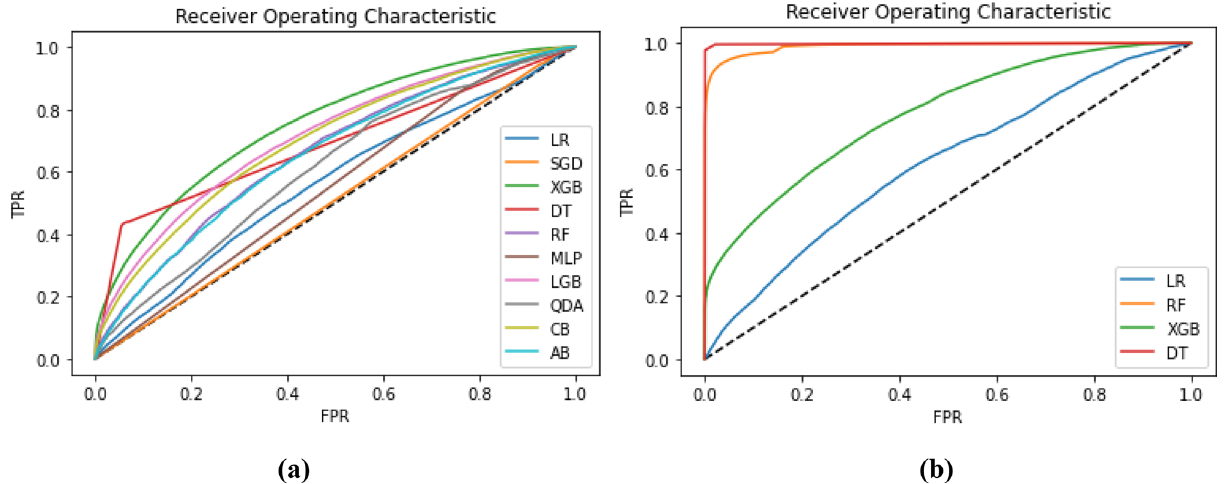
Figure 4. ROC curves—scenario 1 ( a ), scenario 2 ( b